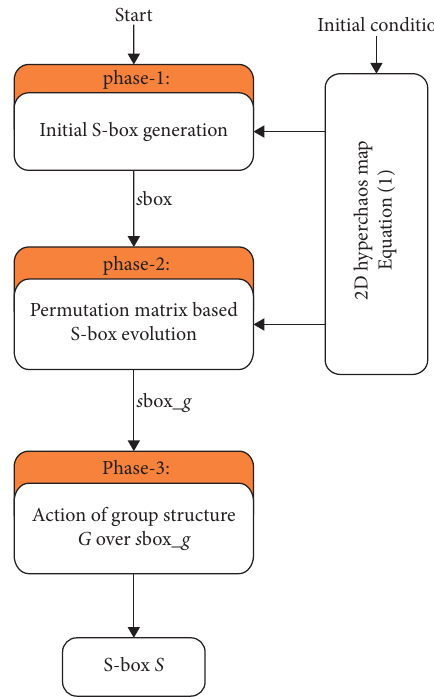
Figure 6: Block diagram of proposed S-box generation method. Table 2: Intermediate S-box after